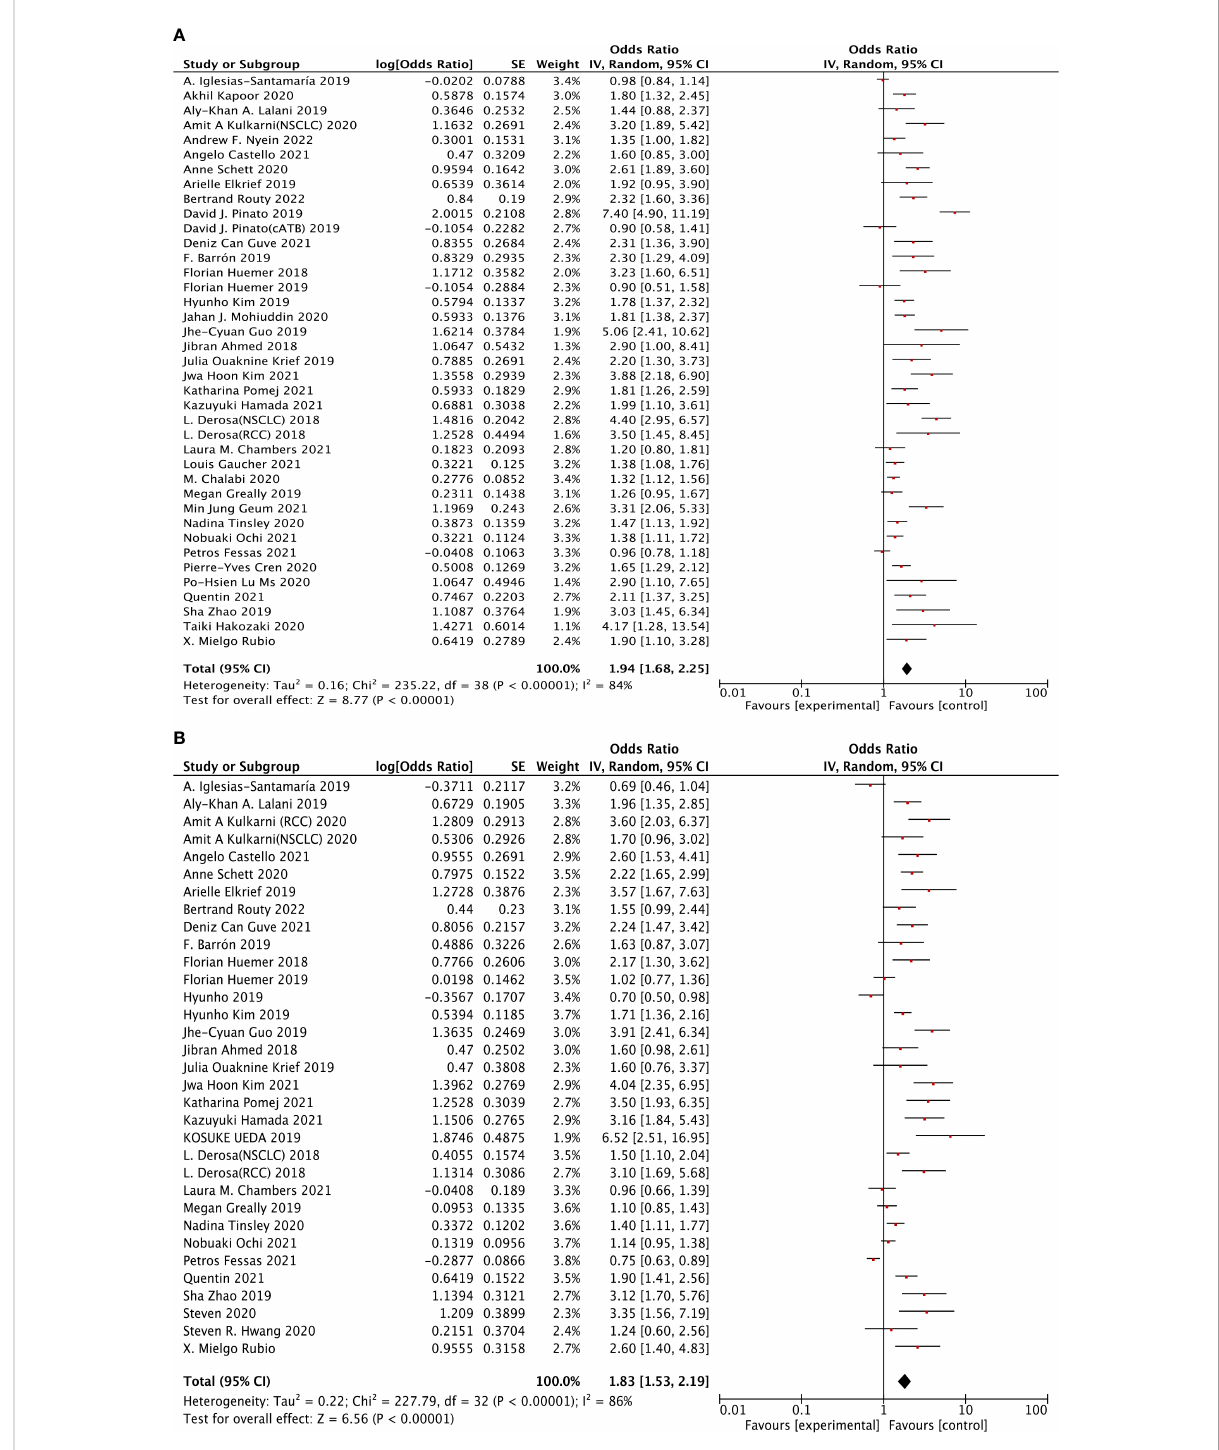
FIGURE 2 The forest plot showing the relationship between ATB use and OS, PFS in cancer patients treated with ICIs. Overall survival (OS), progress-free survival (PFS); CI, con fi dential interval; Random, random-effects model; The random-effects model was adopted. (A) Overall survival (OS). (B) Progress-free survival (PFS). (A) Relationship between ATB use and OS in cancer patients treated with ICIs. (B) Relationship between ATB use and PFS in cancer patients treated with